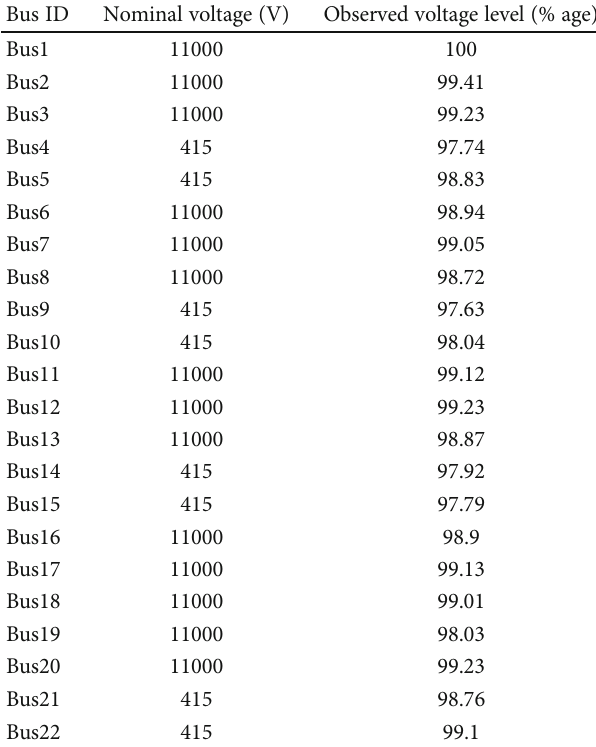
Table 14: Voltage level comparison for all cases.